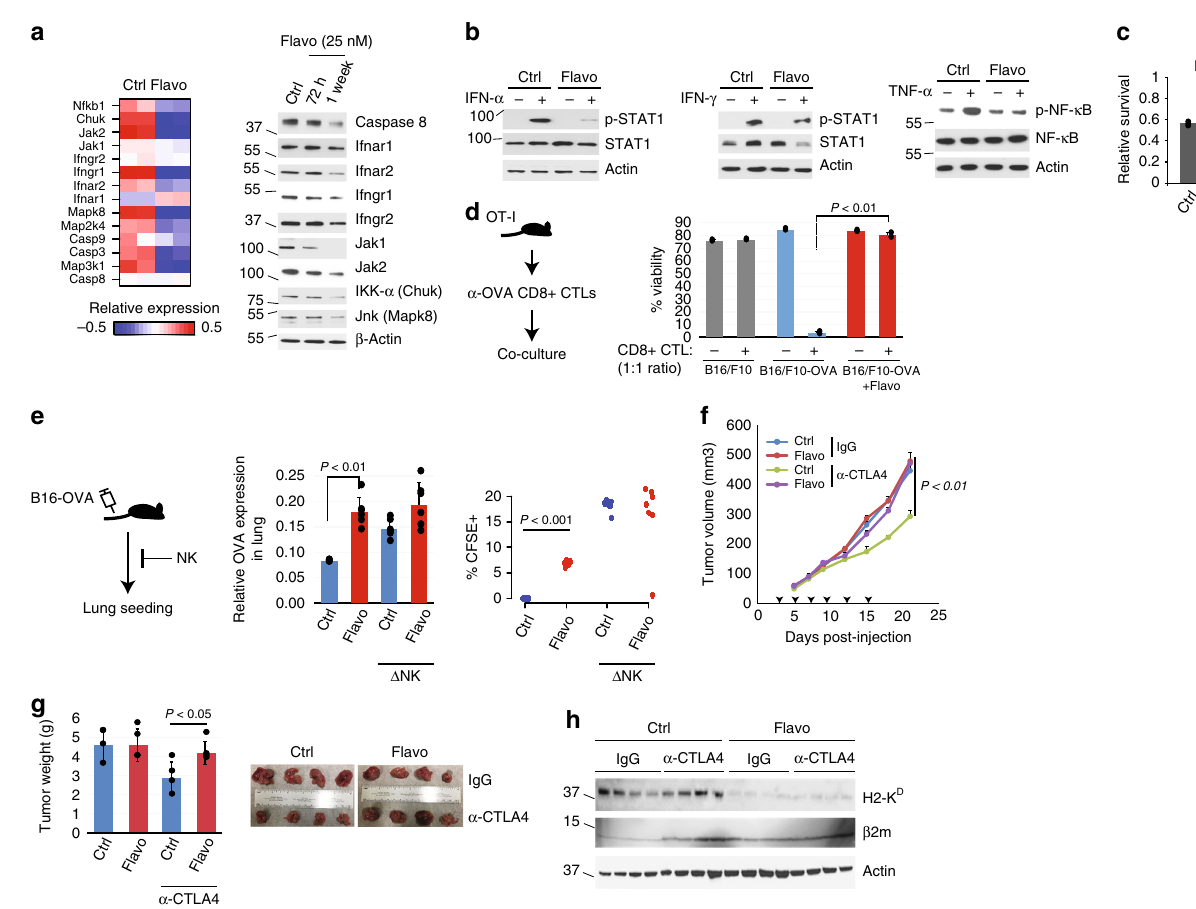
Fig. 7 Chronic TE defects confer resistance to anti-tumor immune attack and immunotherapy in vitro and in vivo. a Heatmap of relative expression (left), and immunoblots for proteins (right), of some key in fl ammatory response pathway genes in control and fl avopiridol-treated cells. b Control and fl avo pre- treated cells were stimulated with IFN- α , IFN γ or TNF- α for 30 mins or FasL ( c ) for 24 h, and the readout was measured with the indicated proteins by immunoblotting ( b ) or viability assay ( c ). d Relative viability of B16/F10-OVA cells co-cultured with activated CD8 + CTLs (1:1 ratio) isolated from the spleens of OT-I mice. P : Welch two-sample t -test, e in vivo assessment of resistance to NK-mediated anti-tumor response: mice are injected intravenously with 2 × 10 5 B16/F10-OVA cells pre-stained with CFSE, and tumor cell seeding in the lungs is assessed 1 h later by measuring OVA mRNA levels in the lungs by qPCR (middle) or by fl ow cytometry for CFSE + cells (right). Δ NK: NK cell depletion by subcutaneous pre-injection of mice with anti-asialo GM antibody 1 day prior to tumor cell injection. The p -value is for Welch two sample t -test. f Tumor growth of control or fl avopiridol pre-treated CT26 mouse carcinoma cells in syngeneic (Balb/c) mice treated with control (IgG) or anti-CTLA4 antibody (9H10), P : Welch two-sample t -test. g Weights and images (bottom) of excised tumors of indicated treatment groups after 21 days post-injection. h Immunoblots of some of the excised tumors from the treatment groups in experiment in f for H2-K D (HLA-I), β 2m, and Actin. Error bars: standard deviations of 3 ( c ), 2 ( d ), 6 ( e ), and 4 ( g )